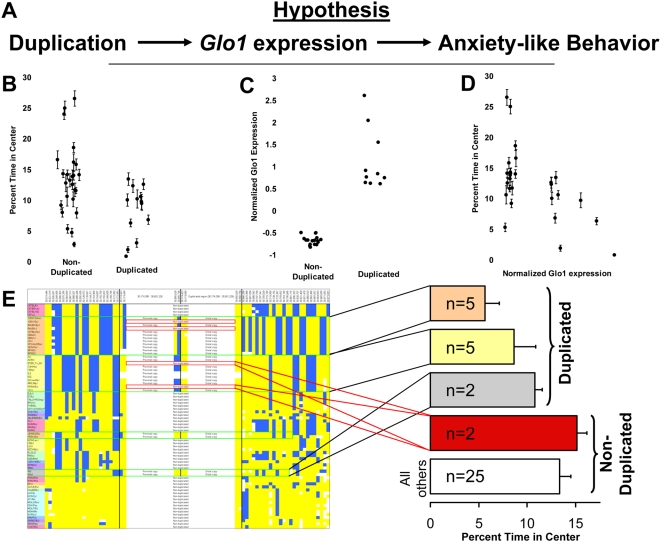
Relationship between behavior, duplication, gene expression and haplotype block.A) hypothesized relationship between the duplication, Glo1 expression and anxiety like behavior; B) Correlation between duplication status and anxiety-like behavior as measured by percent time in the open field and presence of the duplication. A total of 901 male and female mice from 38 inbred strains were tested (n = 5–42 per strain). Random scatter along the x-axis and within duplicated and non-duplicated groups has been added. C) Correlation between duplication status and normalized gene expression in the amygdala from 27 inbred strains. Random scatter has again been added along the x-axis. D) Correlation between normalized Glo1 expression in the amygdala from 27 inbred strains and anxiety-like behavior as measured by percent time in the open field. E) Relationship between haplotype blocks and anxiety-like behavior as measured by percent time in the open field. Behavioral data were obtained from multiple individuals from each of the indicated number of strains, error bars represent the standard error for the mean of strains, not individuals, which would have been much smaller, but statistically inappropriate because the unit of analysis is strains not individuals.